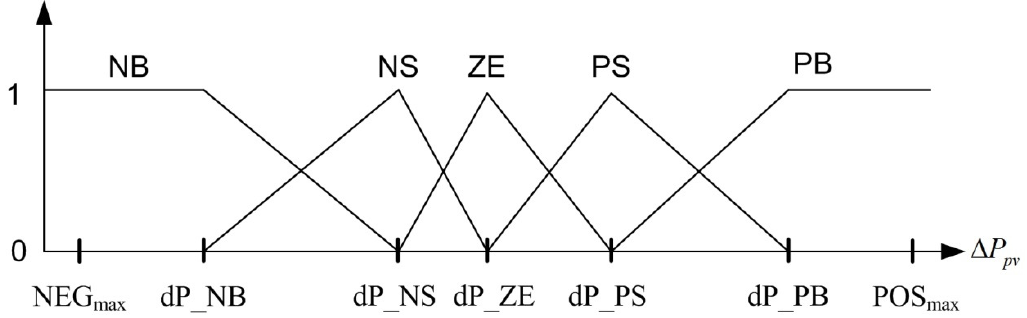
Figure 8. The implementation concept of the MF optimization